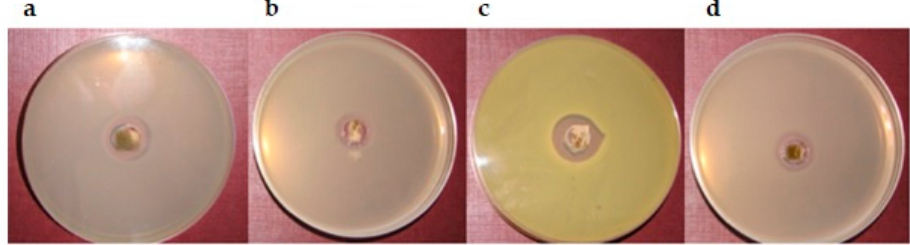
Figure 8. The antimicrobial activity tests of the hydrogels on bacteria: ( a )—F5 on P. acnes (growth inhibition zone 2 mm), ( b )—F6 on P. acnes (growth inhibition zone 2 mm), ( c )—F6 on S. aureus (growth inhibition zone 4 mm), and ( d )—F6 on E. coli (growth inhibition zone 2 mm).